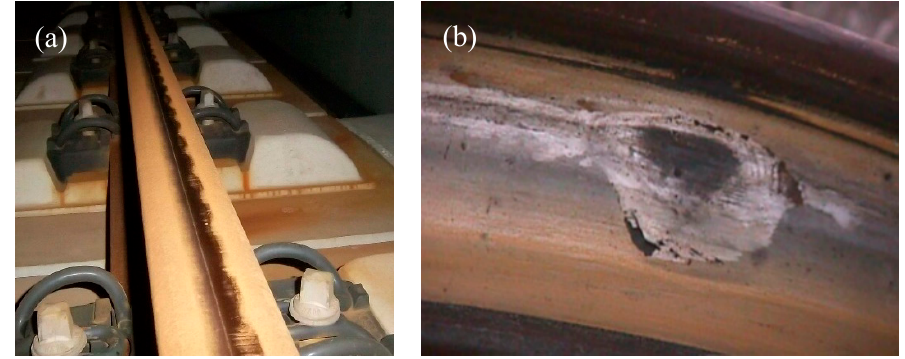
Figure 16. Rail corrugation ( a ) and wheel flat ( b ).